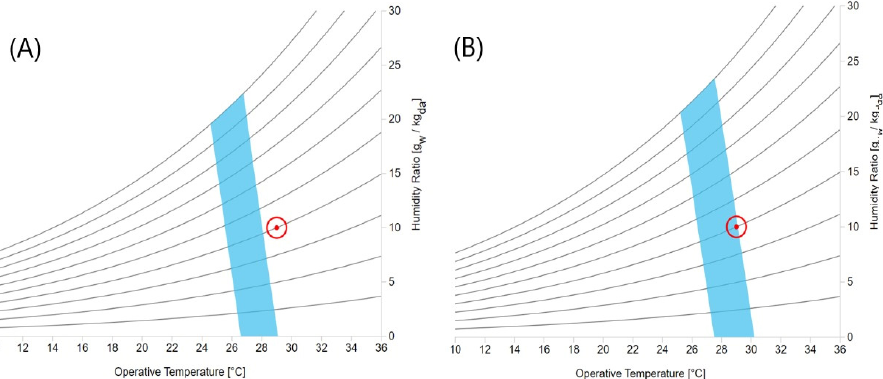
Figure 13. Displacement of the thermal comfort zone (in blue) in a psychrometric chart ( A ) without airflow and ( B ) with induced airflow. The red dot marks the coordinate for a relative humidity of 40% and temperature of 29 °C